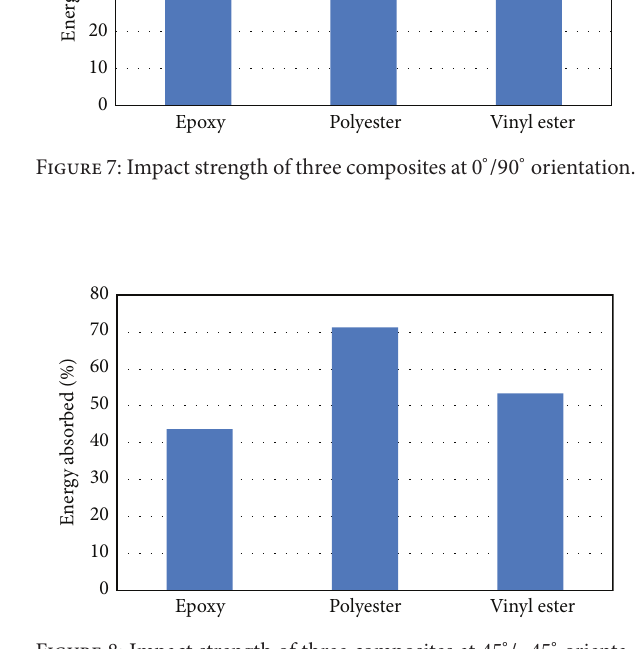
Figure 8: Impact strength of three composites at 45 ∘ / − 45 ∘ orienta-